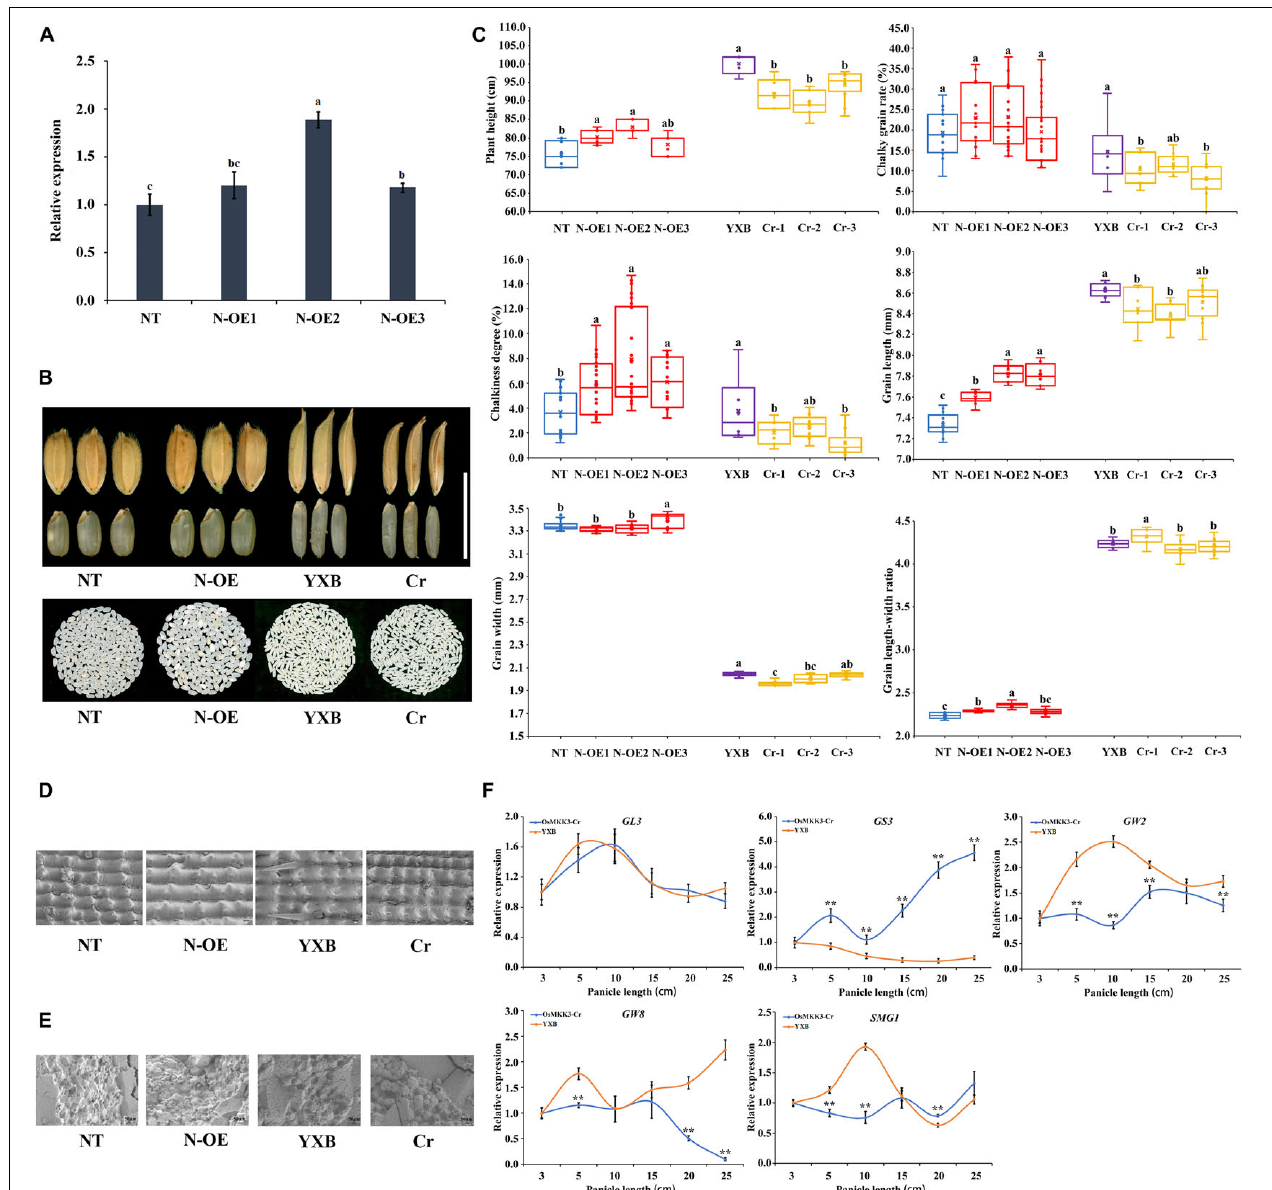
FIGURE 1 | Identification of OsMKK3. (A) Relative expression of OsMKK3 in NT and transgenic plants. (B) Functional validation of the role of OsMKK3 in grain size and chalkiness by genetic transformation. (C) Comparison of the grain length, grain width, chalkiness rate, chalkiness score, and plant height between transgenic plants and NT. Data represent mean ± S.E.M. ( n = 12). Student’s t -tests were used to generate P -values. (D) The epidermal cells of rice husk in transgenic plants and NT. Bar = 1 cm. (E) Scanning electron microscope images of chalkiness in transgenic plants and NT. Bar = 50 µ m. (F) Relative expression of important genes in NT and transgenic plants. a, b, and c represent significant difference at 5% probability level. ** represents significant difference at 1% probability